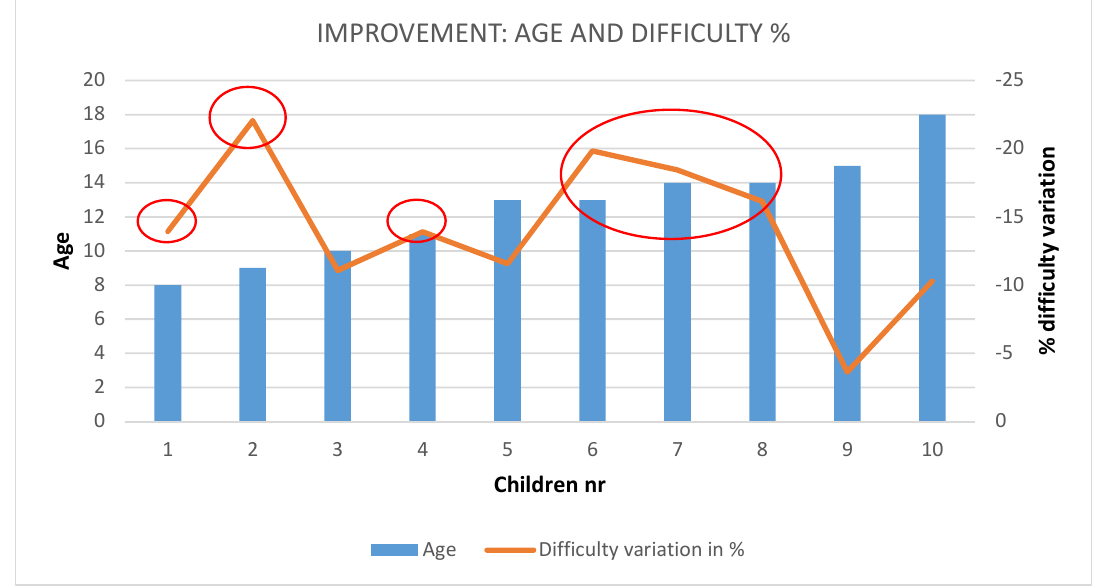
Figure 15. Age (blue, left axis) and improvement (% of decrease on degree of difficulty-right axis).